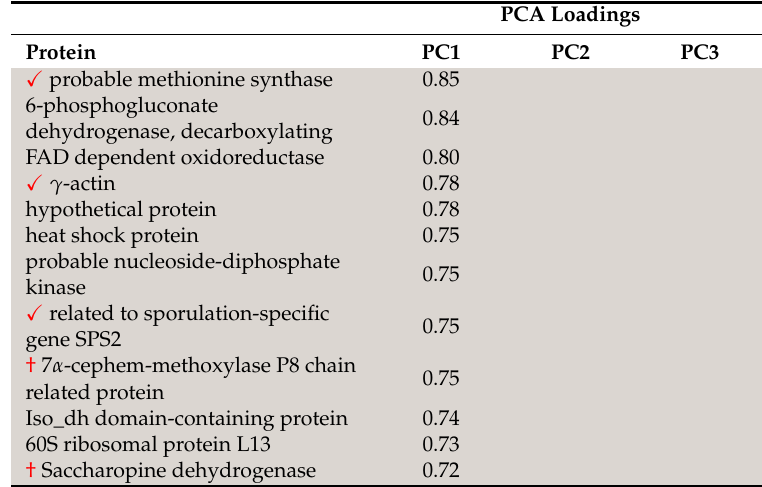
Table A2. Proteome Principal Components Analysis. Shown are the proteins that “load heavily” onto the first three principal component axes. “Heavy” loadings are defined here as | x | ≥ 0.70. Fungal derived proteins are highlighted in pale brown; the plant derived proteins are highlighted in pale green. Proteins that were individually different between 400 ppm and 800 ppm CO 2 for at least one strain of the endophyte are denoted with a †, see Tables A3 and A4. Proteins that load heavily in the integrated OMICs PCA are denoted with (cid:88) , see Table